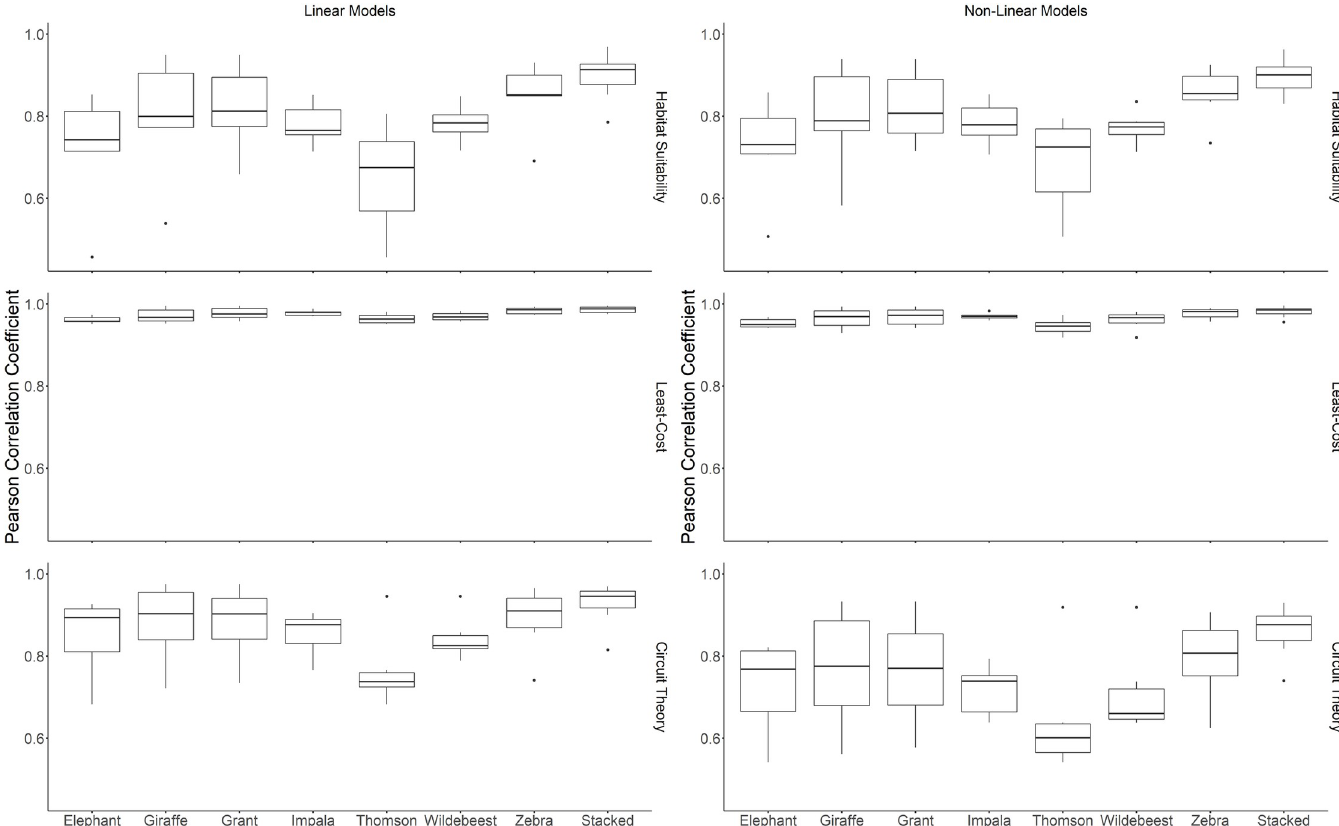
Fig 3. Average pairwise Pearson correlations between the species-specific and stacked multi-species linearly and non-linearly scaled landscape connectivity models.